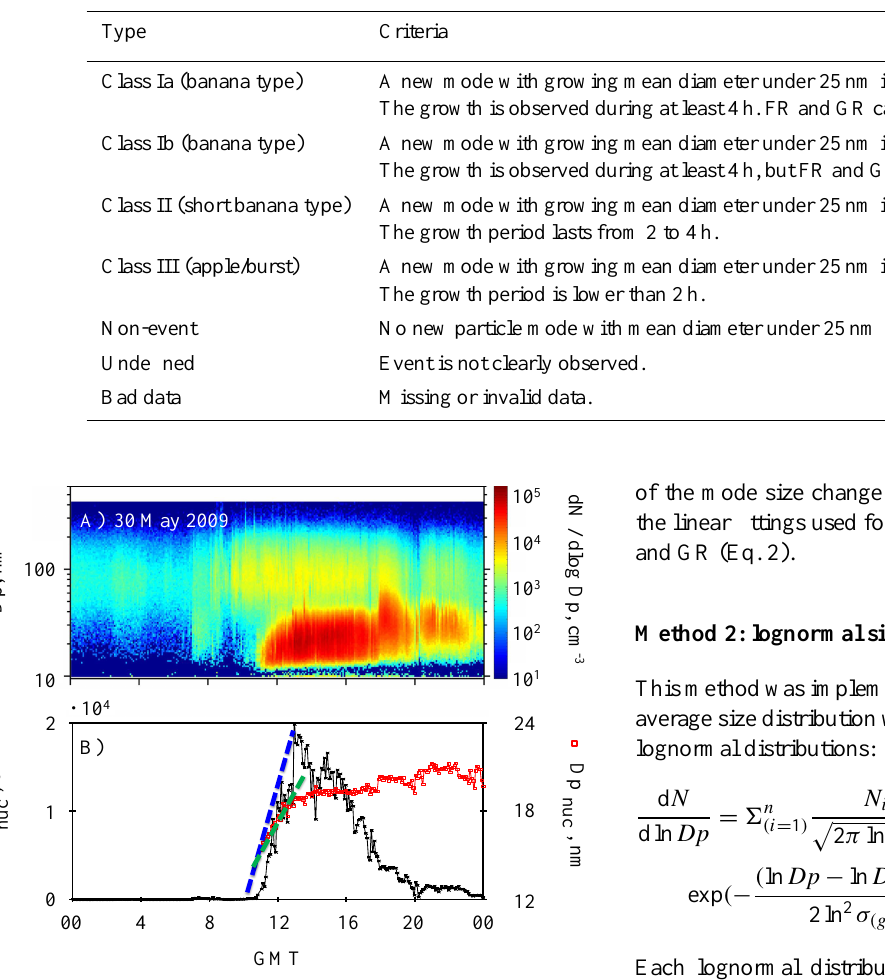
Fig. 4. Example of type Ia event. (A) Time evolution of the particle size distribution of the number of nucleation particles and (B) of the geometric mean diameter for the nucleation mode. Lines illus- trate the fitting that are performed for determining the formation and growth